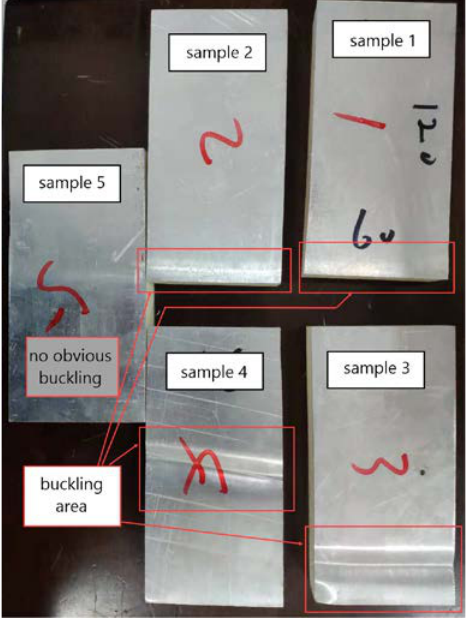
Figure 14. The deformation positions of 5 samples after compression.